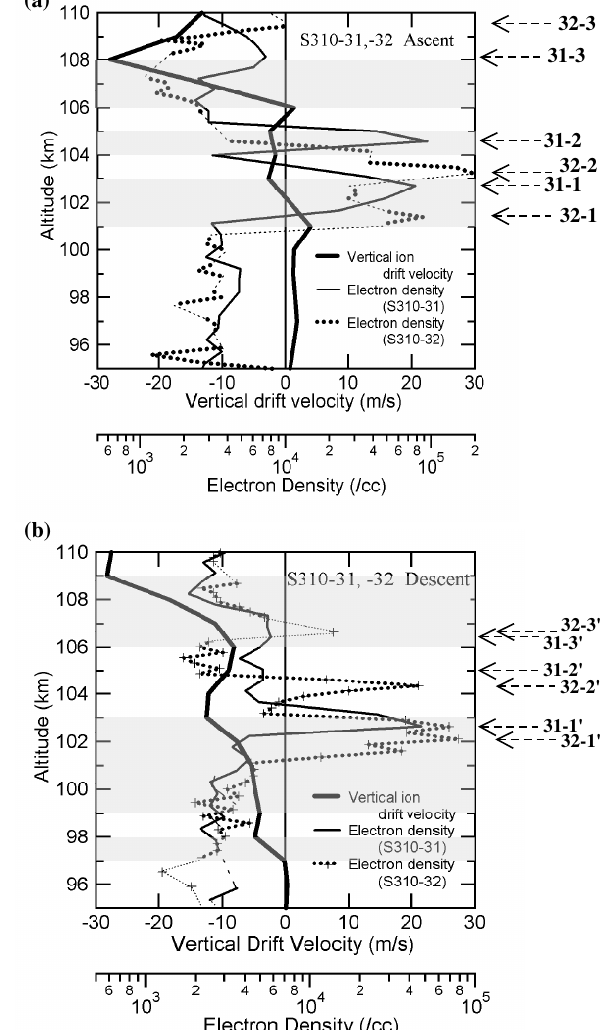
Fig. 3. Ion vertical drift velocity derived from neutral wind and electric field profiles obtained by S310-31 and S310-32